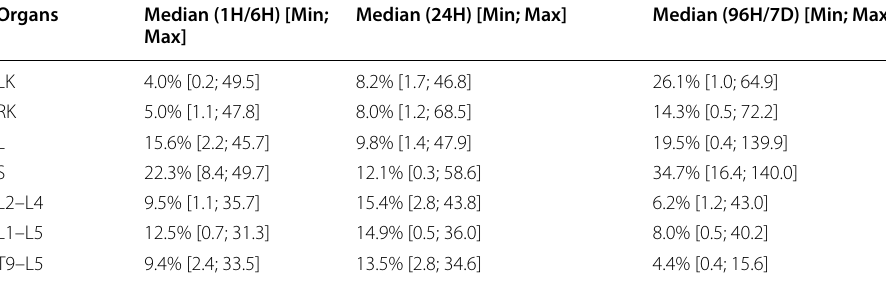
Table 2 Medians of variations coefficients (%) of ODR obtained for each VOI and each time‑point on all patients (patient and validation